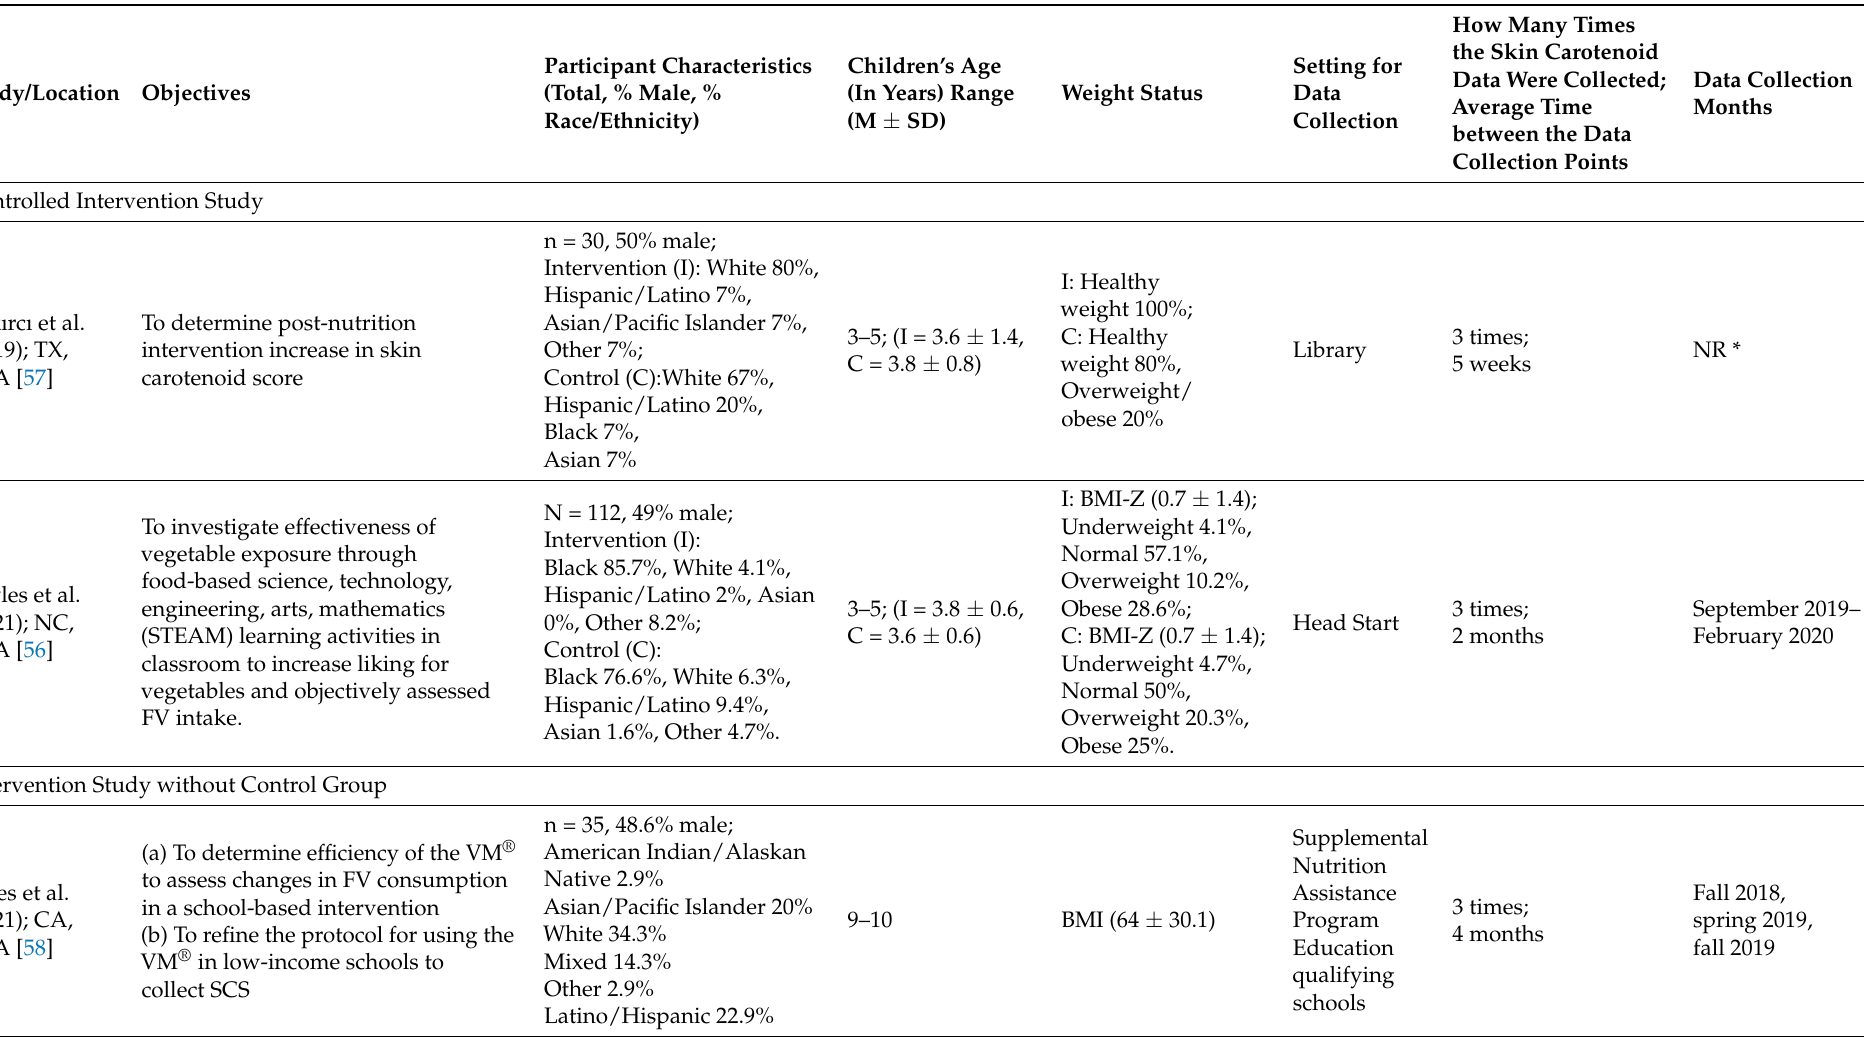
Table 1. Demographic characteristics of study participants and data